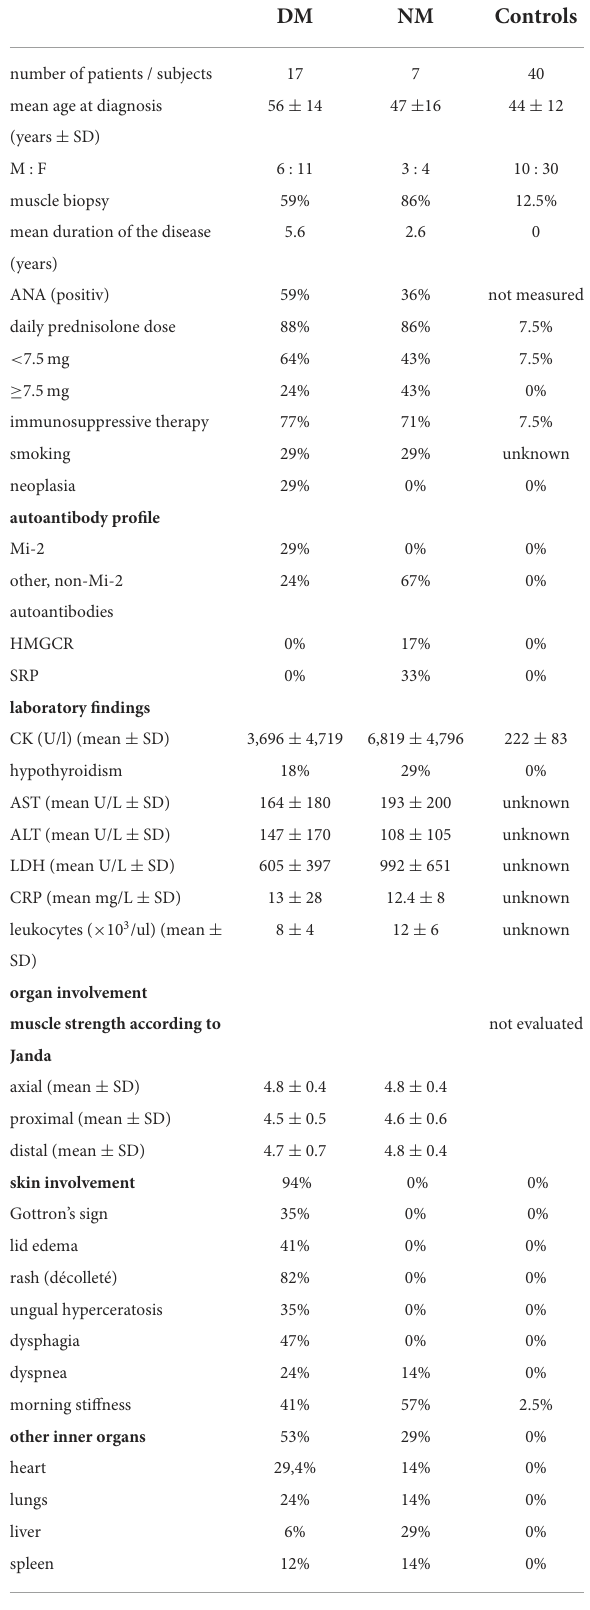
results were depicted by either dot or box plots, depending on TABLE 1 Detailed patients’ characteristics. the number of measurements. The median was marked in every DM NM Controls series. Significant differences were assumed if p -values were below 17 7 40